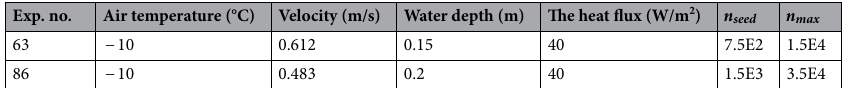
Table 2. Characteristics of the supercooling processes for the laboratory experiment no. 63 and no. 86 by Ye et al.